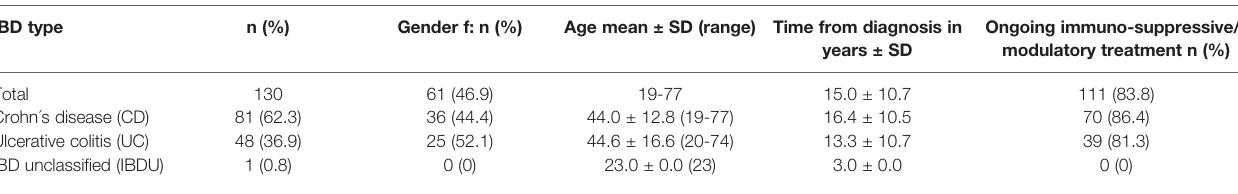
TABLE 2 | Characteristics of IBD